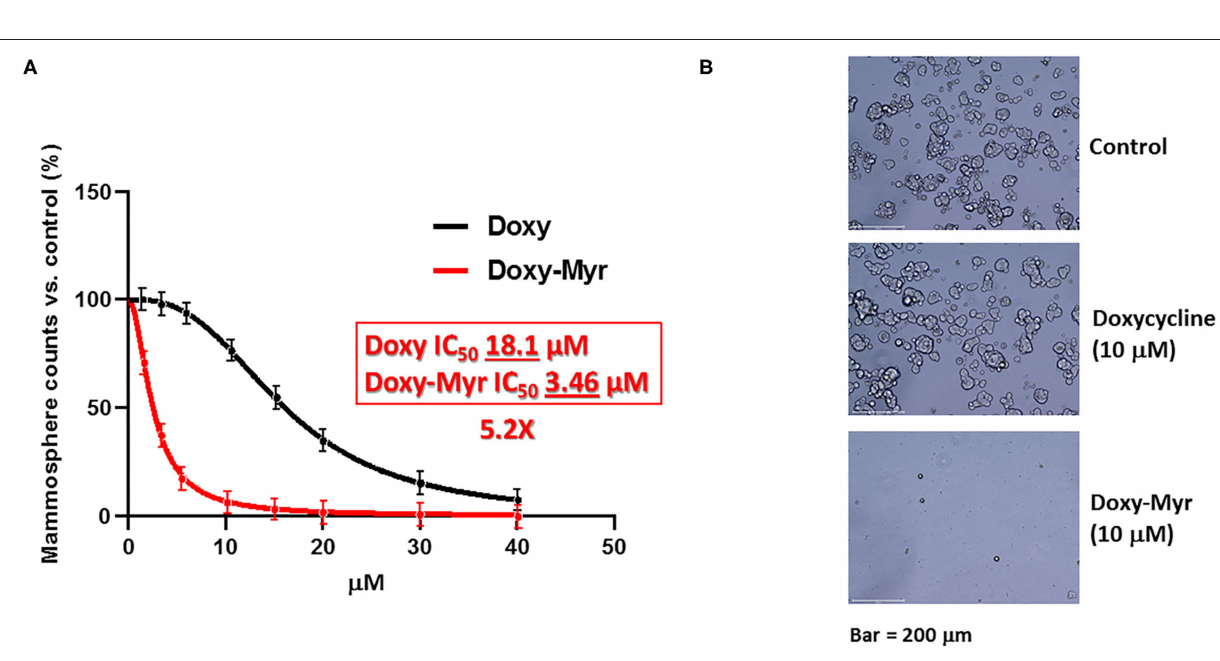
Frontiers in Oncology | www.frontiersin.org